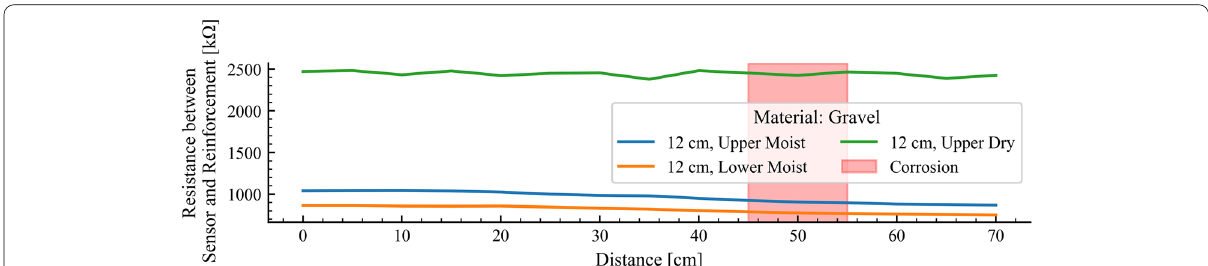
Fig. 13 Electrical resistance between the sensor and the steel reinforcement for gravel as filling material in moist and dry conditions measured with an LCR-meter with a frequency of 120 Hz measured in the upper and the lower row of holes in the wooden frame (see Fig. 11) where the red rectangle marks the location treated with sodium chloride during casting of the sample